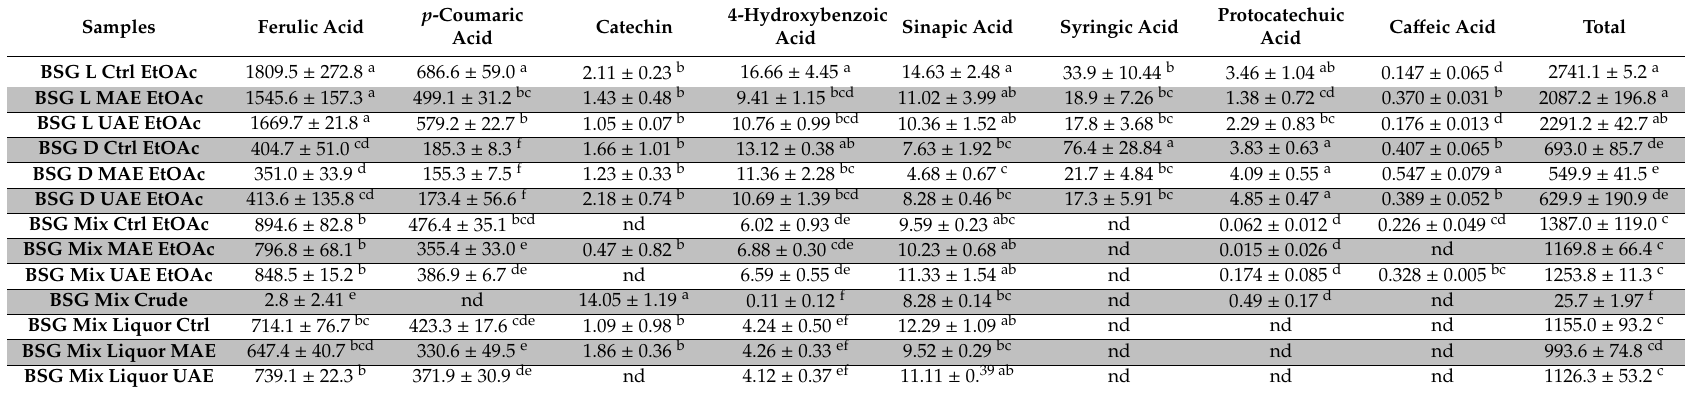
Table 3. UPLC-TQD quantification of BSG polyphenols